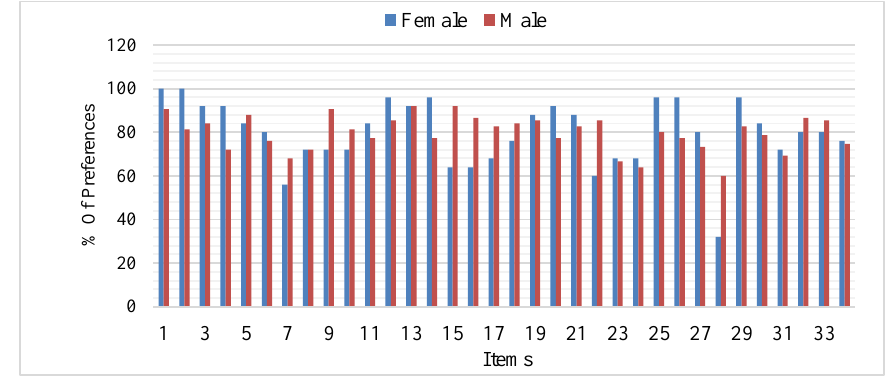
Fig. 2. Preferences of the different items related to the evaluation of the online training course in online EP by gender.